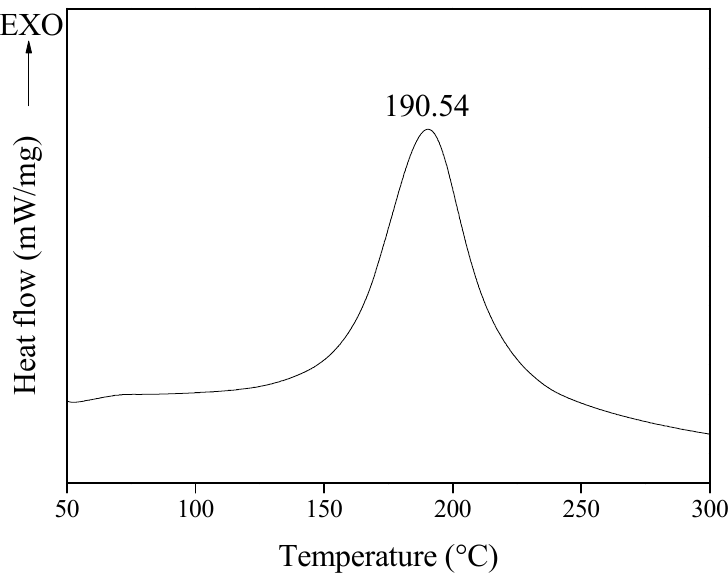
Figure 1. Curing temperature of epoxy/4,4 ′ -diaminodiphenyl sulfone mixture using differential scanning calorimetry.